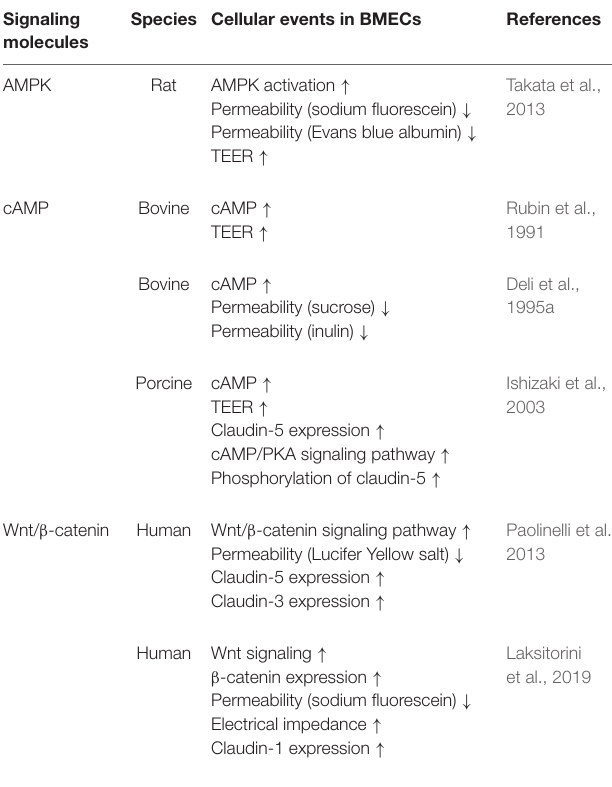
TABLE 2 | Signaling pathways in BMECs that strengthen BBB